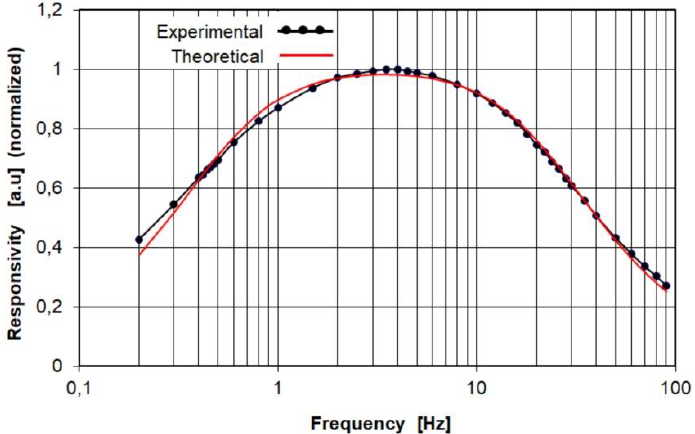
Figure 5. Experimentally (black line with circles) and theoretically (red line) obtained curves illus- trating the frequency dependence of the responsivity R v = f ( f ) of the PE10-S-Q pyroelectric